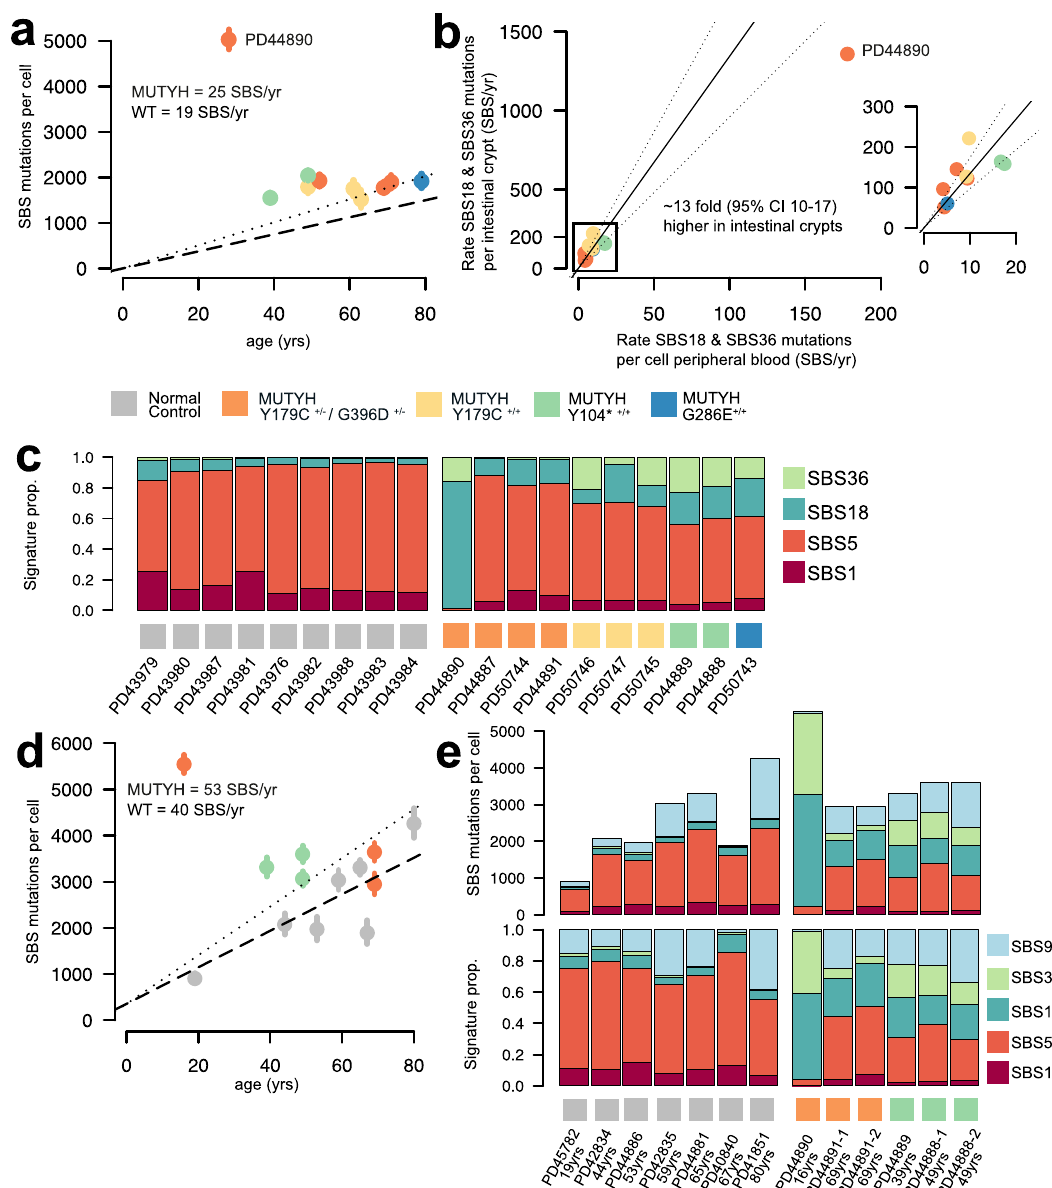
Fig. 4 Mutation burdens and mutational signatures in blood and immune cell populations. a SBS mutation burden in peripheral blood per cell ( x -axis) plotted against the age of the individual in years ( y -axis). Dots are coloured according to the individual ’ s germline mutation; orange; MUTYH Y179C + / − G396D + / − , yellow; MUTYH Y179C + / + , green; MUTYH Y104* + / + and blue; MUTYH G286E + / + . Whiskers represent the 95% con fi dence interval. Dashed line represents the mutation rate in wild-type (WT) normal control samples, dotted line represents the mutation rate in MUTYH samples (linear mixed-effects-model) 50 . b Mutation rate of MUTYH associated mutational signatures; SBS18 and SBS36 per cell for peripheral blood (SBS/yr)(x-axis) against the SBS18 & SBS36 mutation rate of normal intestinal crypts (SBS/yr)(y-axis). Each dot represents one individual and they are coloured according to the individual ’ s germline mutation; orange; MUTYH Y179C + / − G396D + / − , yellow; MUTYH Y179C + / + , green; MUTYH Y104* + / + and blue; MUTYH G286E + / + . The rate of MUTYH associated mutational processes is ~13x fold (linear model, 95% C.I.; 10-17) higher in intestine vs blood. Black line indicates the ratio, and dotted lines the 95% C.I.. Plot inset shows the mutation rate for n = 9 patients excluding the outlier, PD44890. c Stacked bar plot displaying the mutational signature contribution in each peripheral blood sample organised by patient. Coloured squares indicate the MUTYH germline mutation. Normal control data from granulocytes sequenced using the same method (data from Abascal et al 2021) 50 . Signi fi cantly higher proportion of SBS18 and SBS36 is observed in individuals with MUTYH mutations vs normal healthy controls (two-sided Wilcoxon rank sum, P = 0.00004). d SBS mutation burden in intestinal lymphocyte cells from wild-type healthy individuals (grey) and individuals with MUTYH mutations (coloured according to the germline MUTYH genotype) plotted against age (years). Dots represent median values and whiskers represent the 95% con fi dence interval. Dashed line indicates the rate of increase of SBS burden in wild-type lymphocytes (40 SBS/yr, linear mixed- effects model, R 2 = 0.68, 95% C.I., 13-66, P = 0.01) and dotted line indicates the rate of increase in SBS burden in lymphocytes from individuals with MUTYH mutations (53 SBS/yr, linear mixed-effects model, R 2 = 0.68, 95% C.I., 21 – 85, P = 0.01). e Stacked bar plots showing the absolute (above) and relative (below) contributions of each mutational signature in tissue lymphocytes from wild-type healthy individuals and individuals with MUTYH mutations. Source data are provided as a Source Data fi